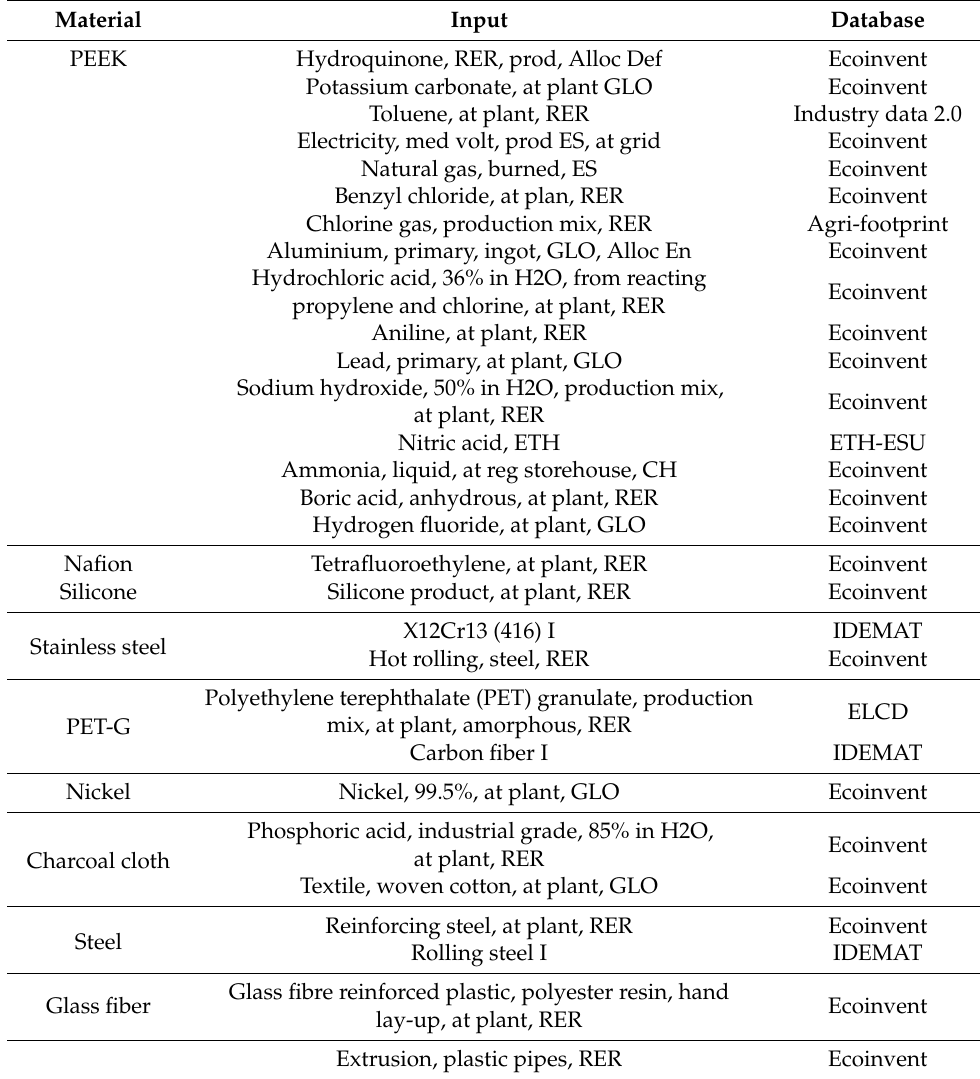
Table 2. Inventory sources considered for the